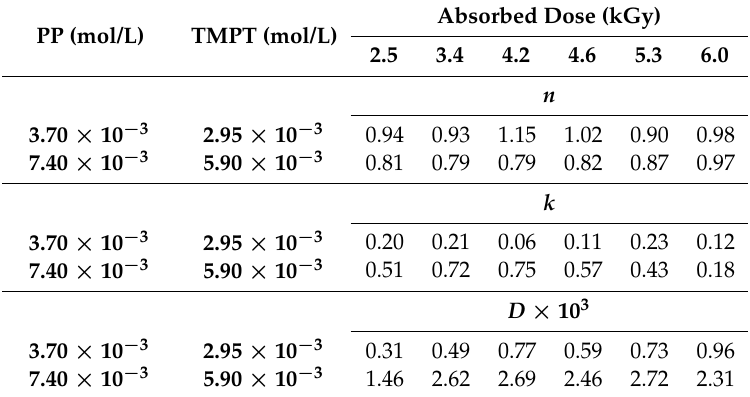
Figure 8. Plots of F versus t 1/2 for hydrogels obtained at: ( a ) 2.5 kGy, 3.4 kGy and 4.2 kGy; ( b ) 4.6 kGy, 5.3 kGy and 6.0 kGy. 5.3 kGy and 6.0 kGy. Table 5. The variation of n , k and diffusional coefficient ( D × 10 − 3 /cm 2 · sec − 1 ) with the amount of TMPT and absorbed